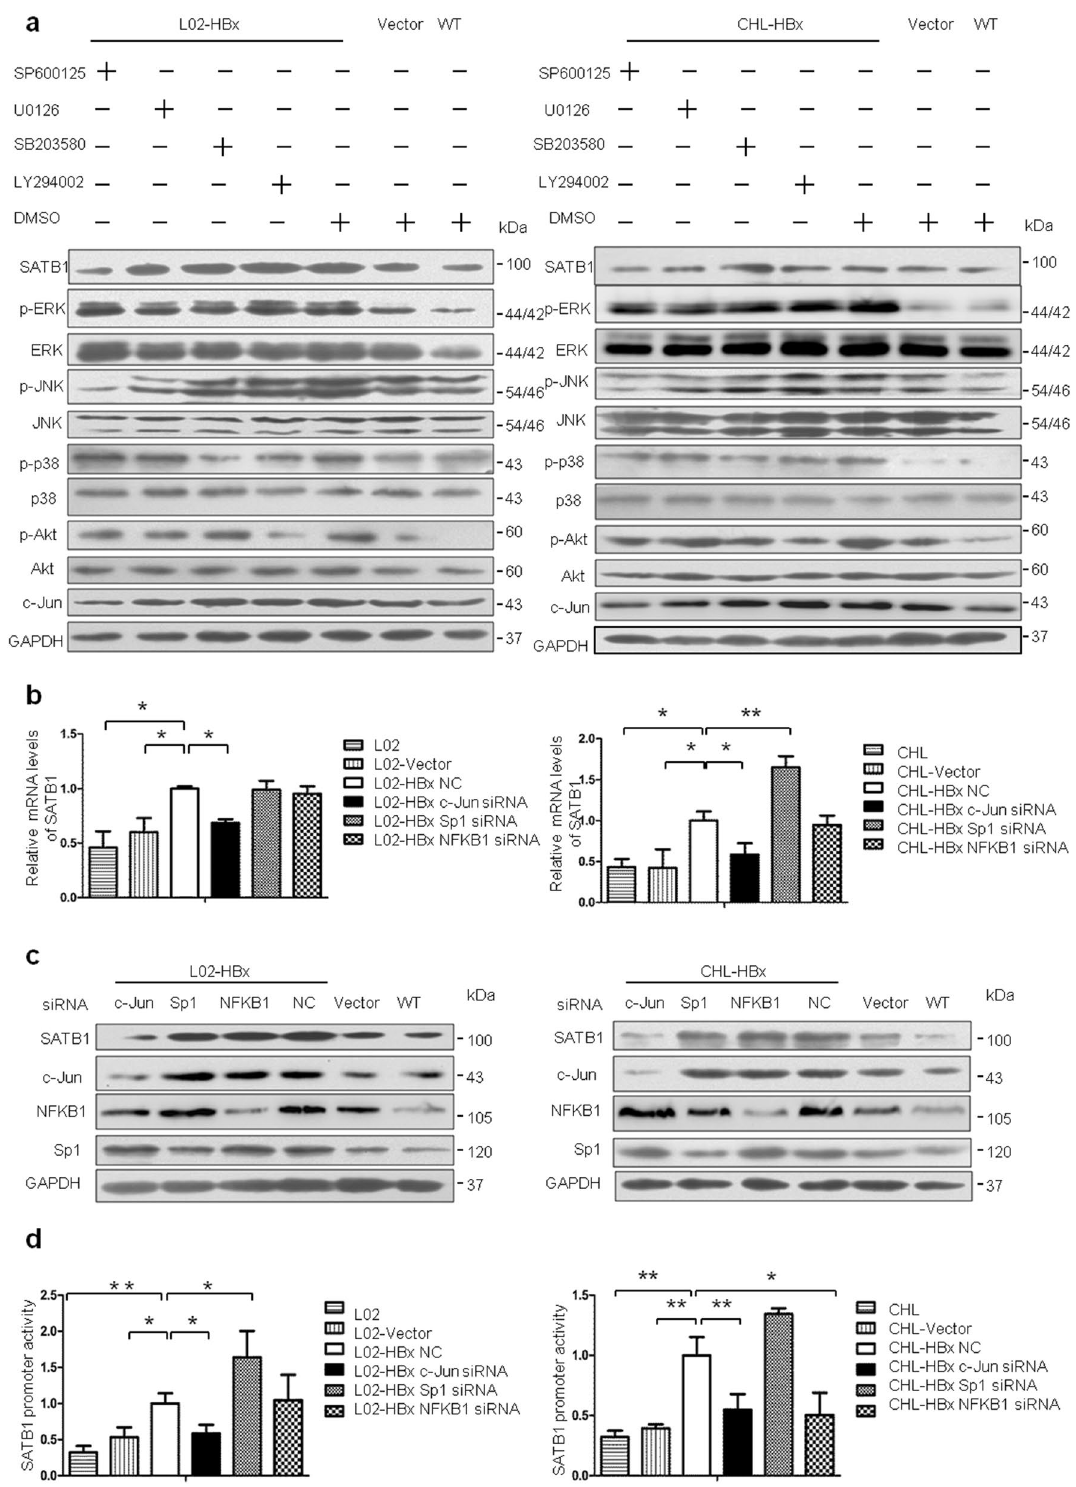
Figure 1. A correct version of the original Figure